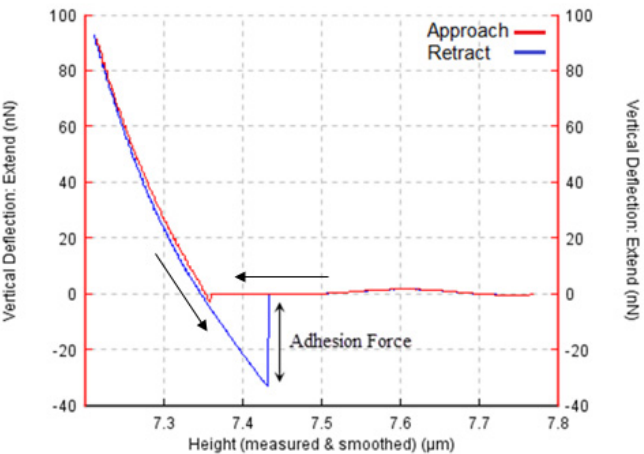
Figure 4. The force-distance curve of the silver substrate with gold-coated AFM tip.